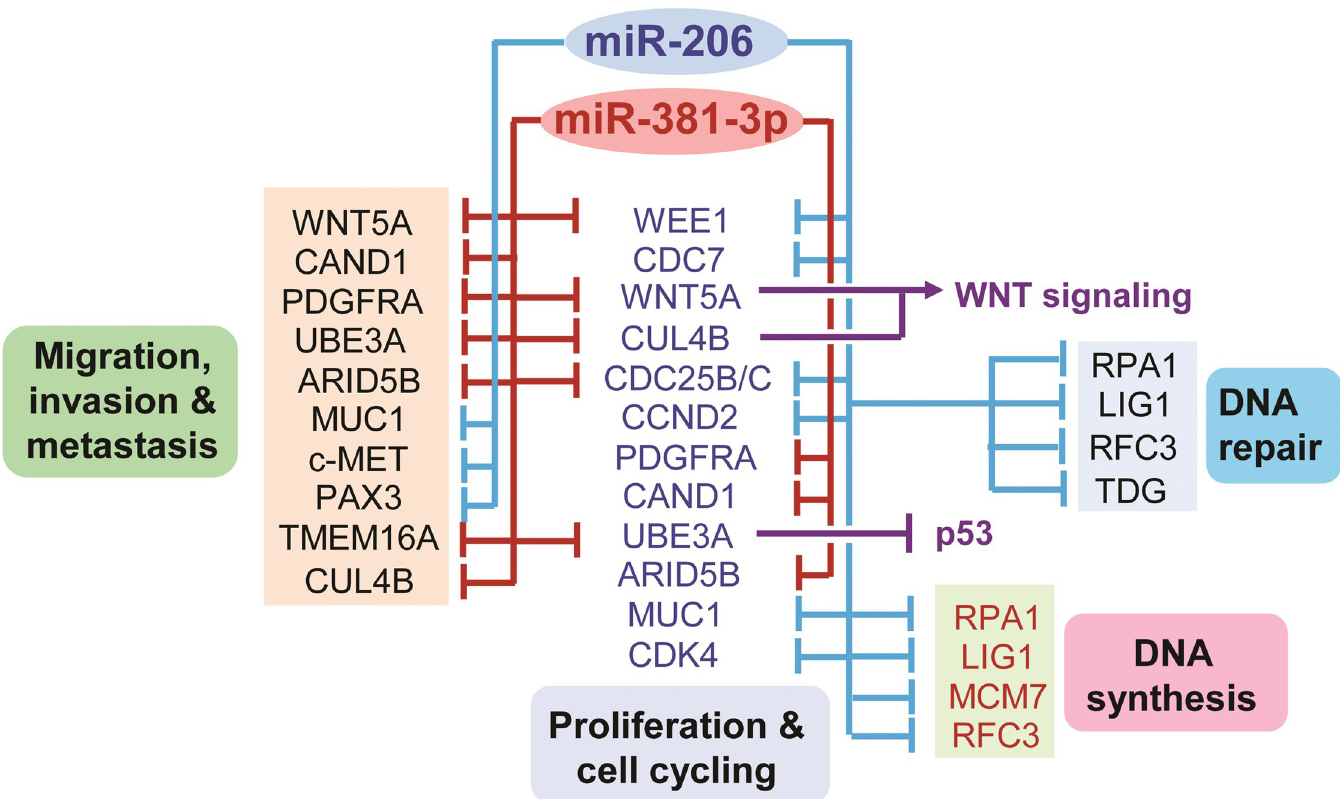
Fig 7. Putative molecular regulatory network mediating the effects of miR-206 and miR-381-3p on carcinogenesis. This diagrams was created based on experimentally validated miRNA/mRNA interactions (obtained from TarBase) within cancer-related processes for miR-206 and miR-381-3p.